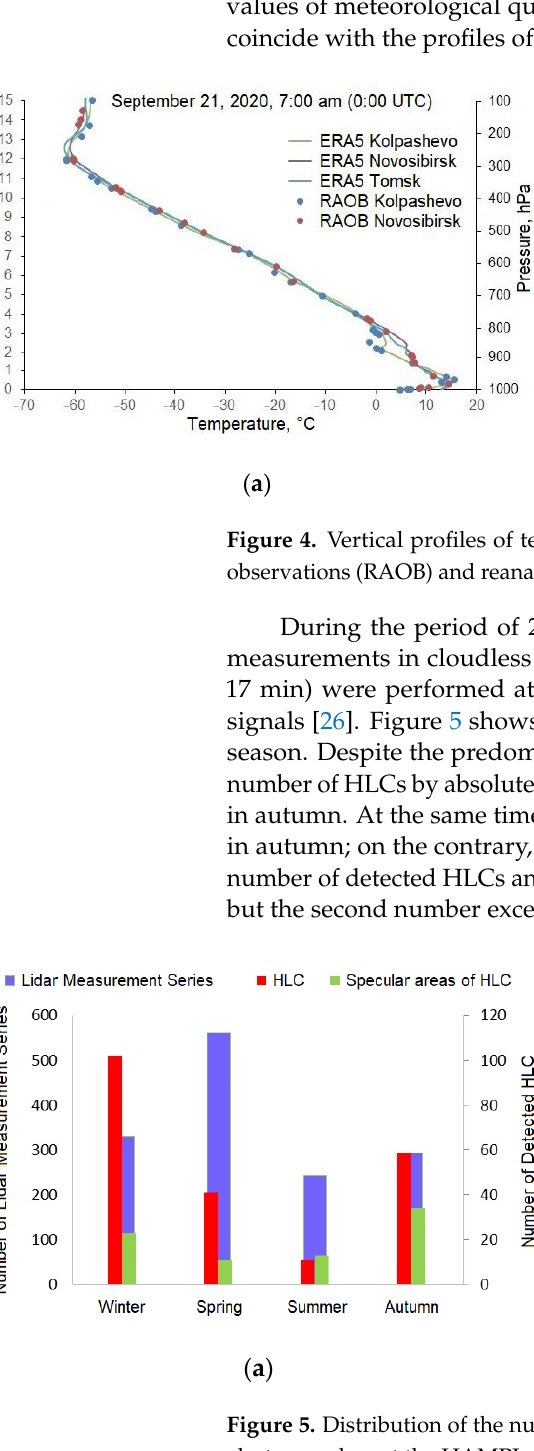
Figure 5. Distribution of the number of measurement series with the parallel accumulation of photoelectron pulses at the HAMPL ( a ) and specular HLCs registered with it ( b ) by season (2016–